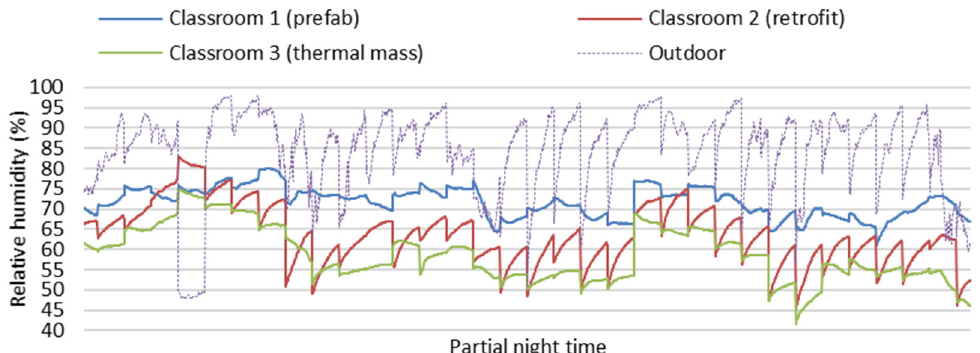
Figure 9. Field study data of indoor relative humidity of the three classrooms during winter nights (7 p.m. to 7 a.m.).